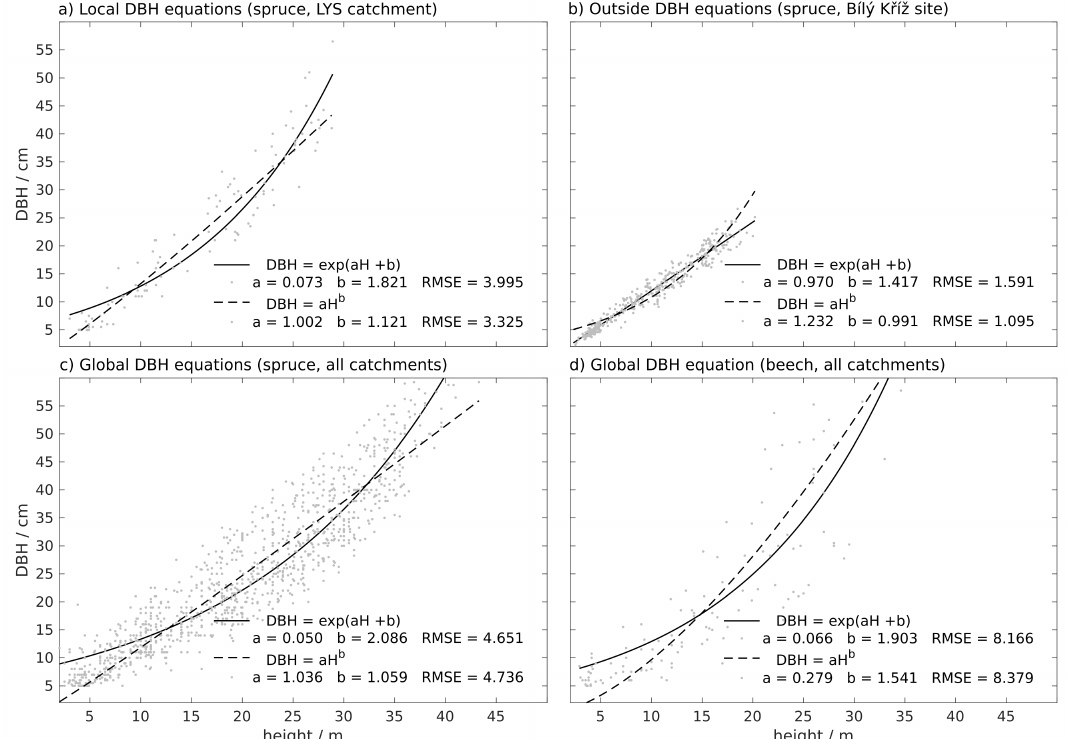
Figure 3. Allometric equations for prediction of stem diameter at breast height (DBH) from tree height (H). ( a ) local model for Norway spruce established for the LYS catchment, ( b ) local model for the external site Bílý Kˇríž, ( c ) global model for Norway spruce computed from all catchments, and ( d ) global model for European beech computed from all catchments. Graphs for local equations from other sites are presented in Supplementary Material